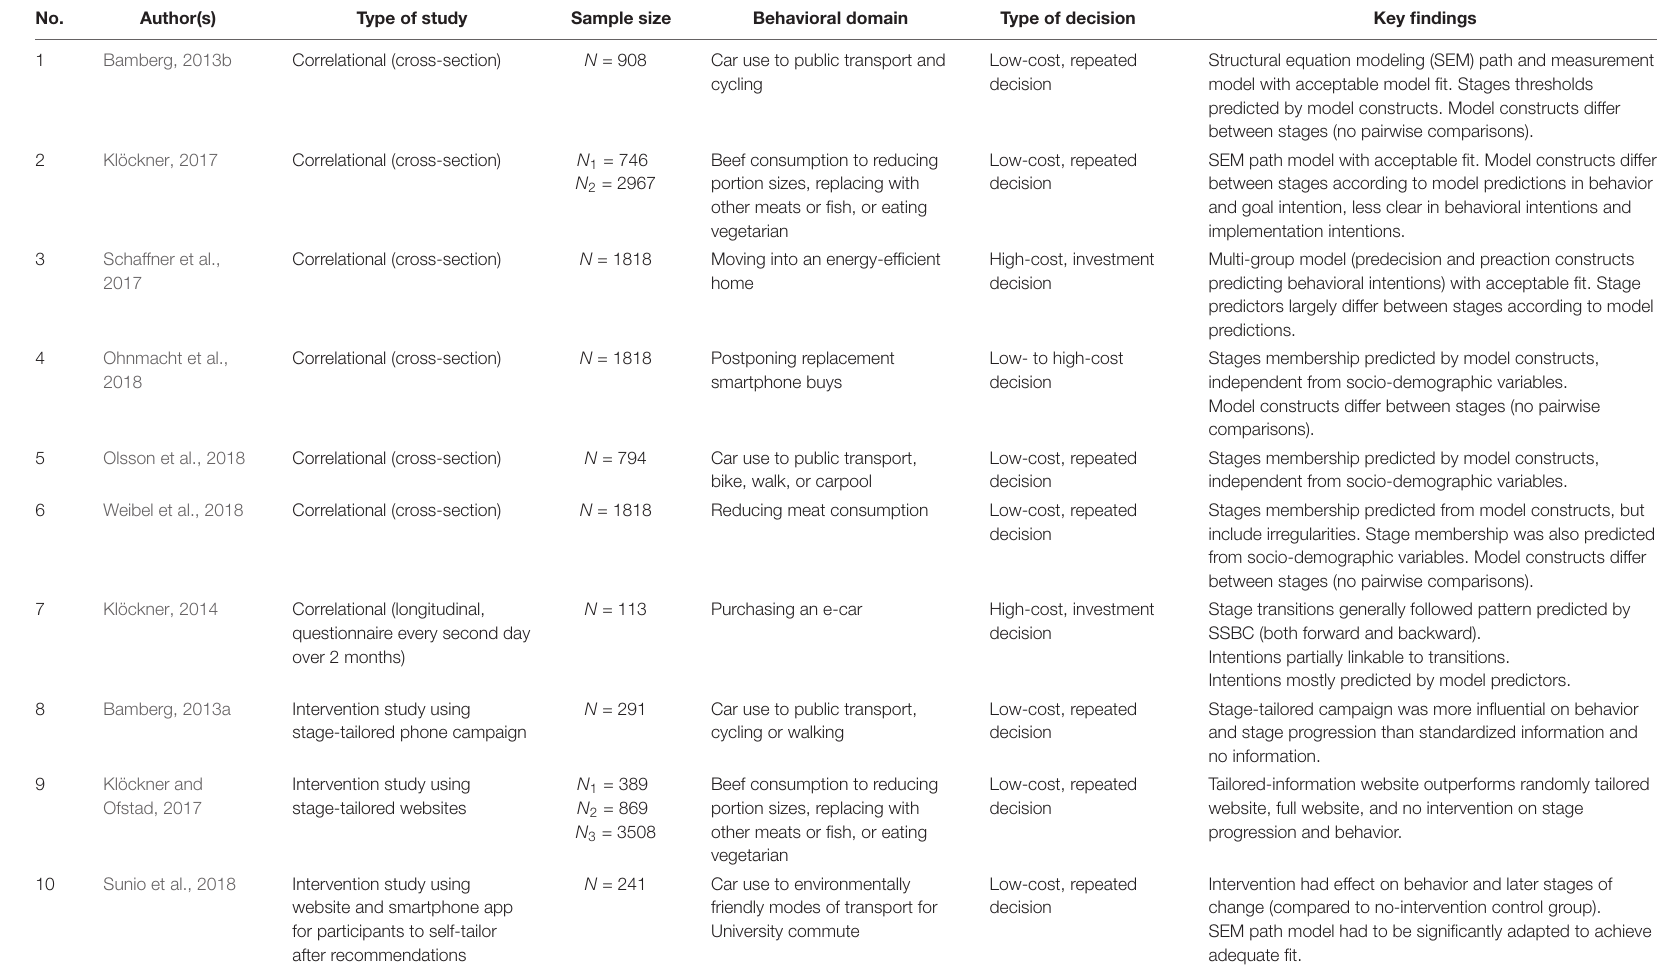
TABLE 1 | Summary of articles included in